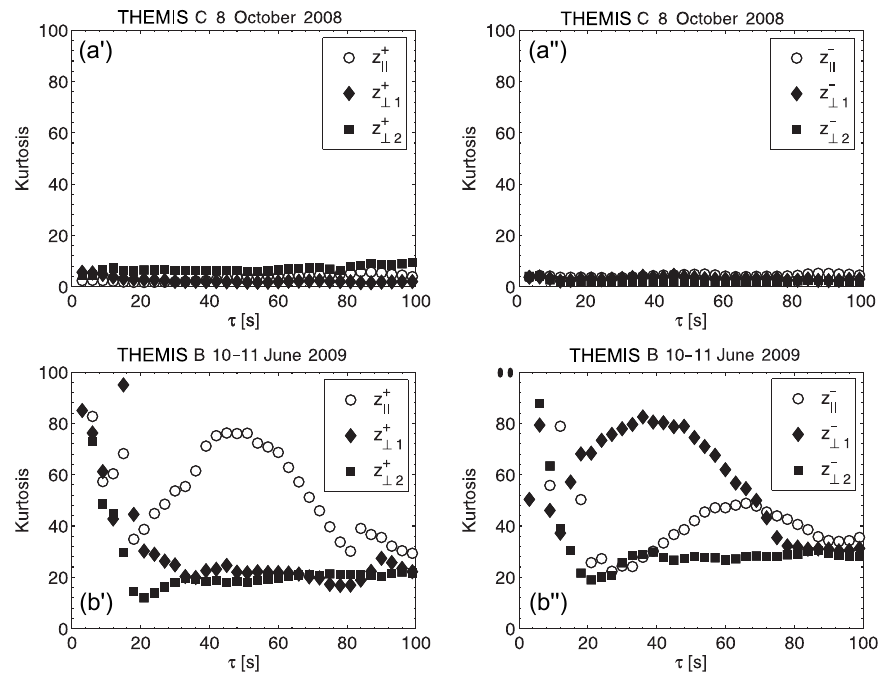
Figure 14. Kurtosis for the increments of the parallel (white circles) and two perpendicular (black diamonds and squares) components of the Elsässer variables, δ z + (a’, b’) and δ z − (a”, b”), as a function of timescale τ near the bow shock (cases (a) and (b) in Table 2).